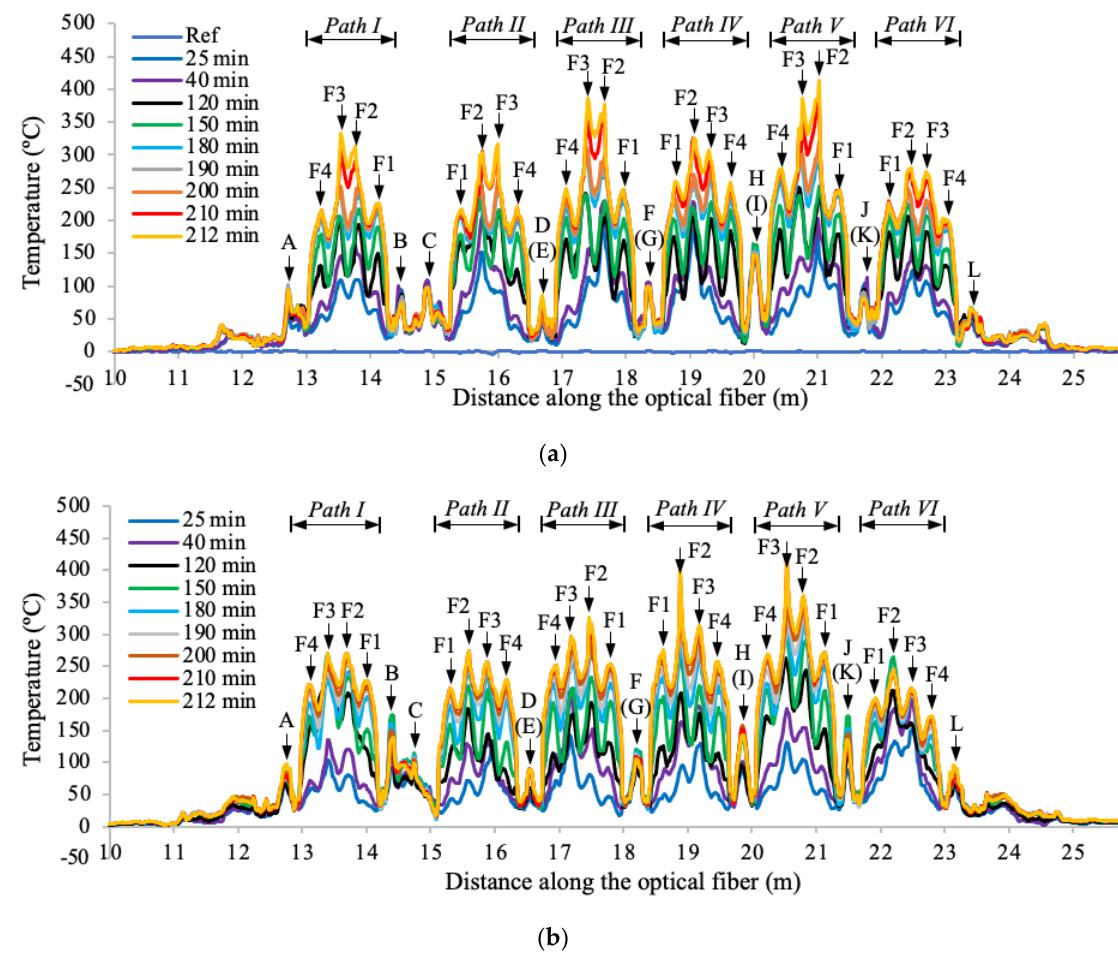
Figure 8. Surface temperature distributions measured from DFOS-4 in: ( a ) CS-5, and ( b ) CS-6. “F1” to “F4” stand for Flute 1 to Flute 4 shown in Figure 3e.